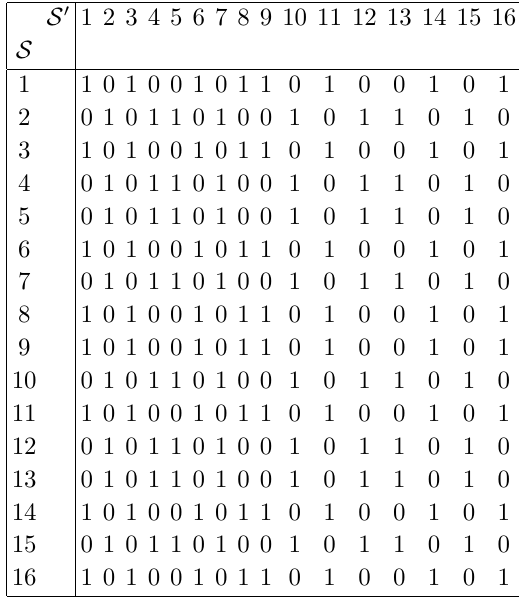
(cid:2) P with di(cid:11)erent boolean factors. [4] [4]